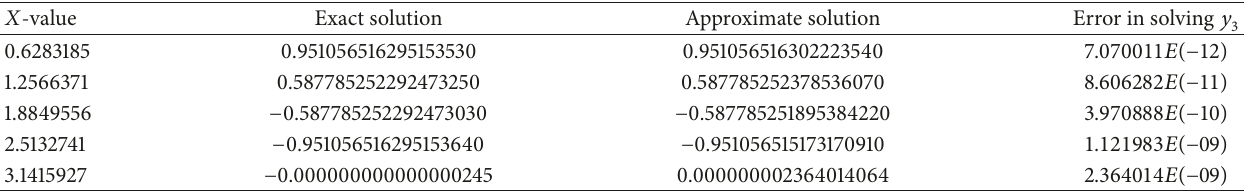
Table 11: Exact and approximate solutions for solving 𝑦 3 using the developed method. 𝑋 -value